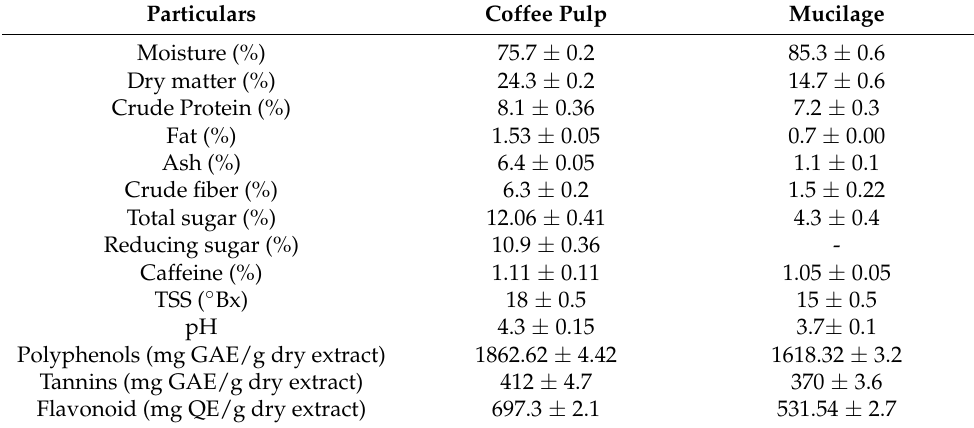
Table 1. Analysis of coffee pulp and